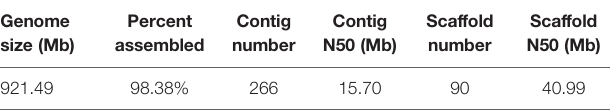
TABLE 2 | Statistics of the Hi-C assembly of the A. ommaturus genome.